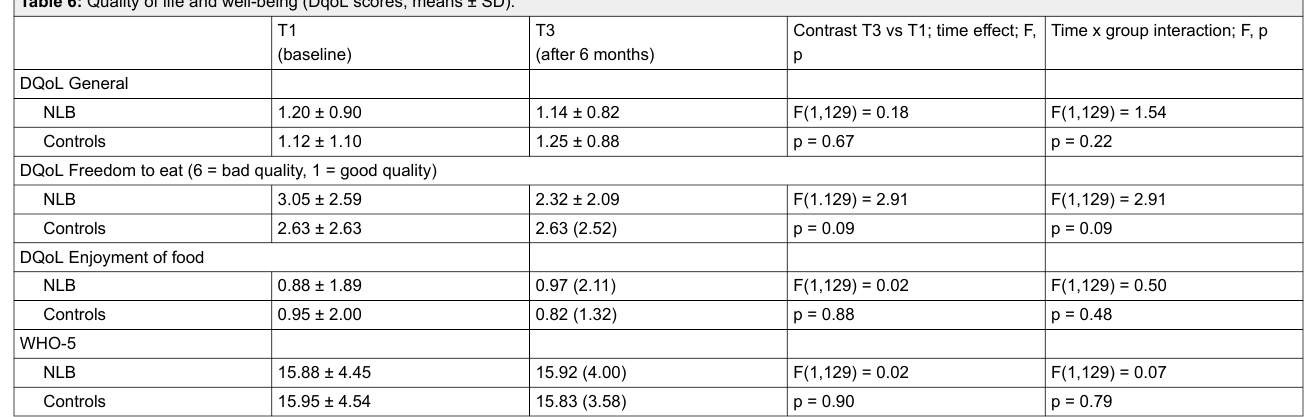
Table 6: Quality of life and well-being (DqoL scores; means ± SD).